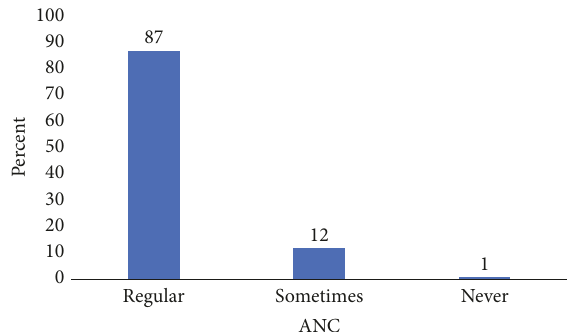
Figure 2: Type of violence the study participants experienced at home in Arba Minch Zuria District, Ethiopia, 2017.